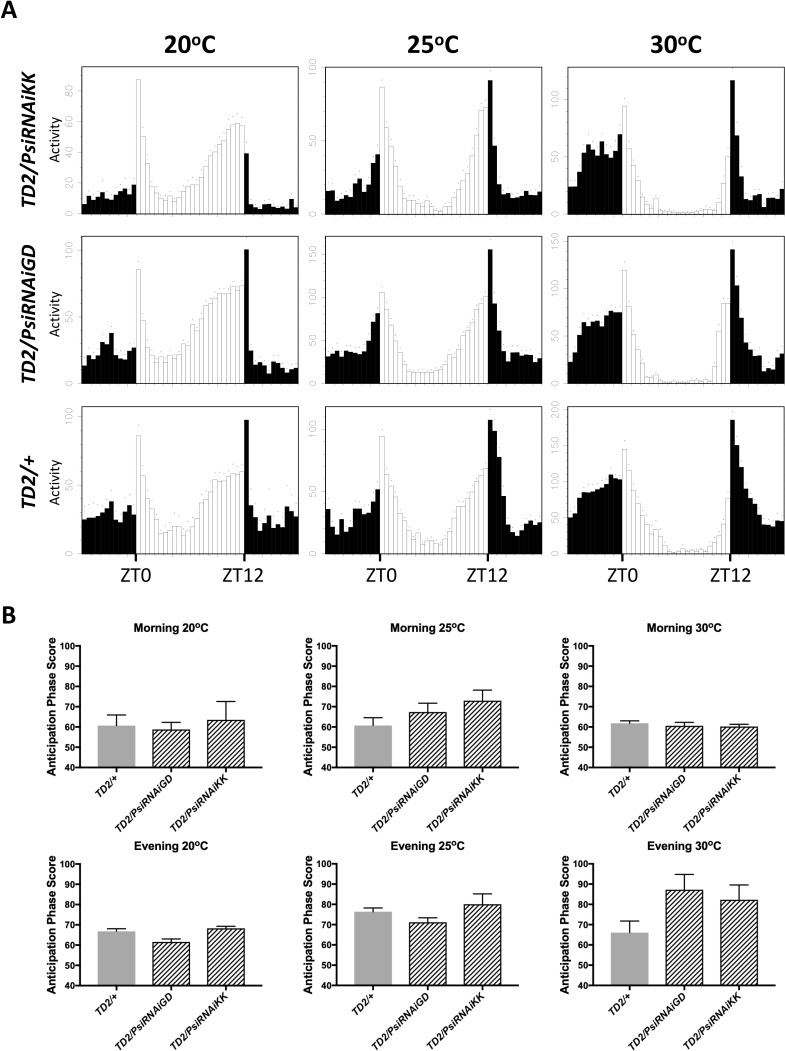
Psi knockdown flies have normal behavioral adaptation to temperature.(A) Eductions showing the average activity of flies during 3 days of LD (days 2–4). Left panels: flies were entrained at 20°C. Center panels: flies were entrained at 25°C. Right panels: flies were entrained at 30°C. Top panels: TD2/PsiRNAiKK (Psi knockdown) flies. Middle panels: TD2/PsiRNAiGD (Psi knockdown) flies. Bottom panels: TD2/+ (control) flies. Note that, similar to the TD2/+ control, Psi knockdown flies advance the phase of their evening activity at 20°C and delay the phase of their evening activity at 30°C. Psi knockdown flies also show reduced morning activity and increased evening activity at 20°C, and increased morning activity and decreased evening activity at 30°C, similar to the TD2/+ control. (B) Quantification of the morning and evening anticipation phase score indicates that the phase of behavior in LD (day 2–3) is not affected by knockdown of Psi. Genotypes are on the x axis. Error bars represent SEM. Gray bar: driver control. Patterned bars: Psi knockdown. One-way ANOVA followed by Tukey’s multiple comparison test: p>0.05 for all comparisons. N = 3–5 runs (6–16 flies per genotype in each run).Figure 3—figure supplement 2—source data 1.Psi downregulation – anticipation phase.Figure 3—figure supplement 2—source data 2.Figure statistics – Figure 3—figure supplement 2.